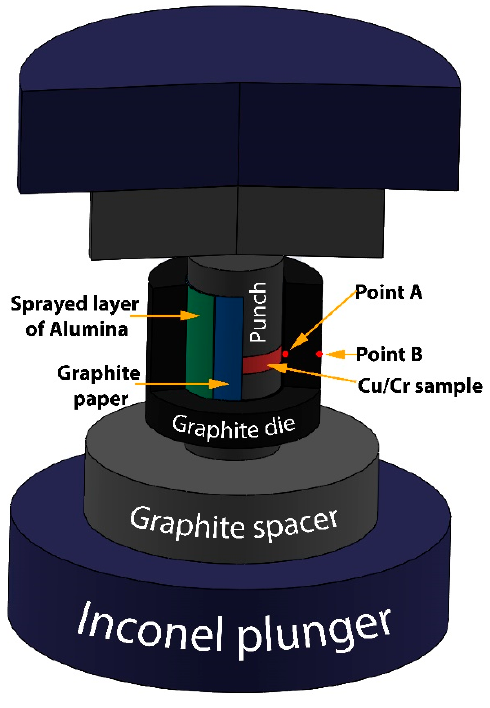
Figure 1. Schematic of the FSPS sintering